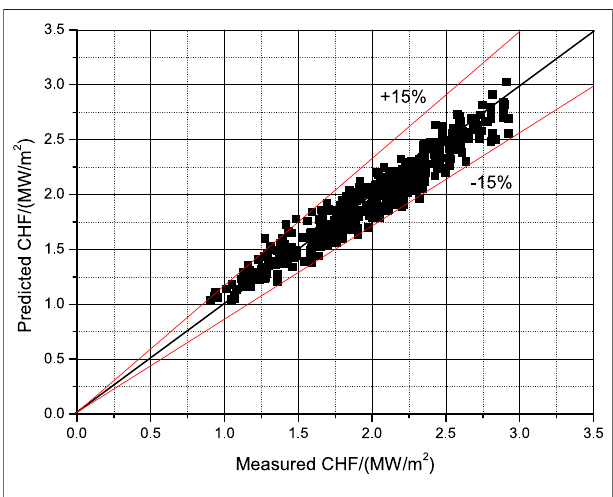
FIGURE 16 | Predicted CHF as a function of measured